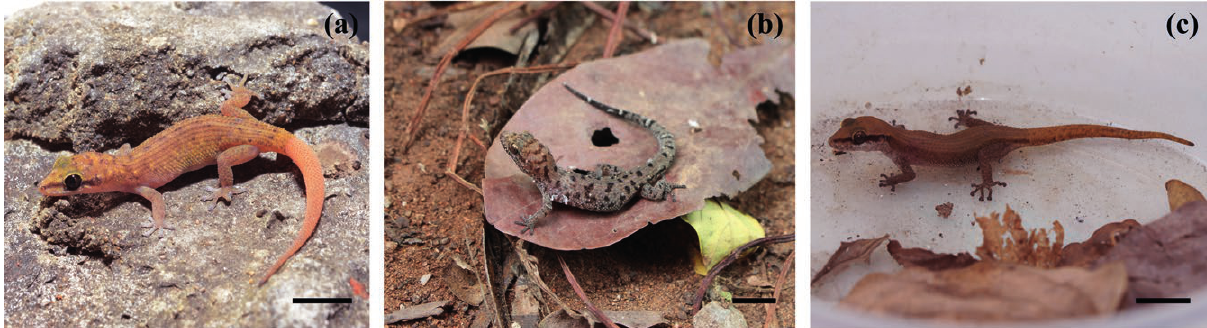
Figure 1. General characteristic of the D. hangseesom (a), D. siamensis (b) and D. melanostictus (c) from Thailand. Scale bars indicate 1 cen-